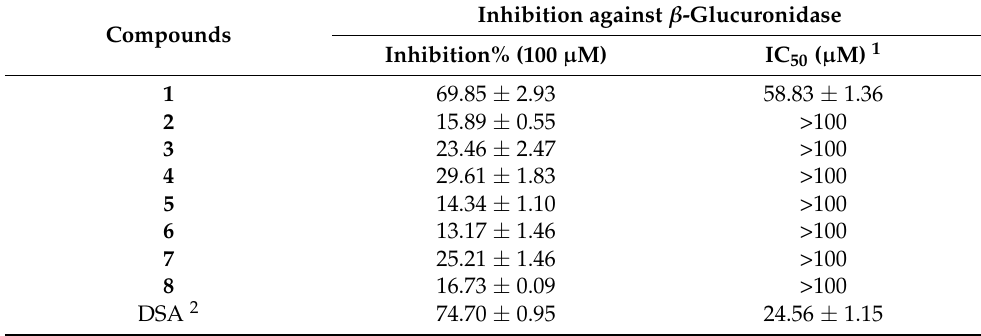
Table 1. Inhibition of compounds 1 – 8 against β -glucuronidase.